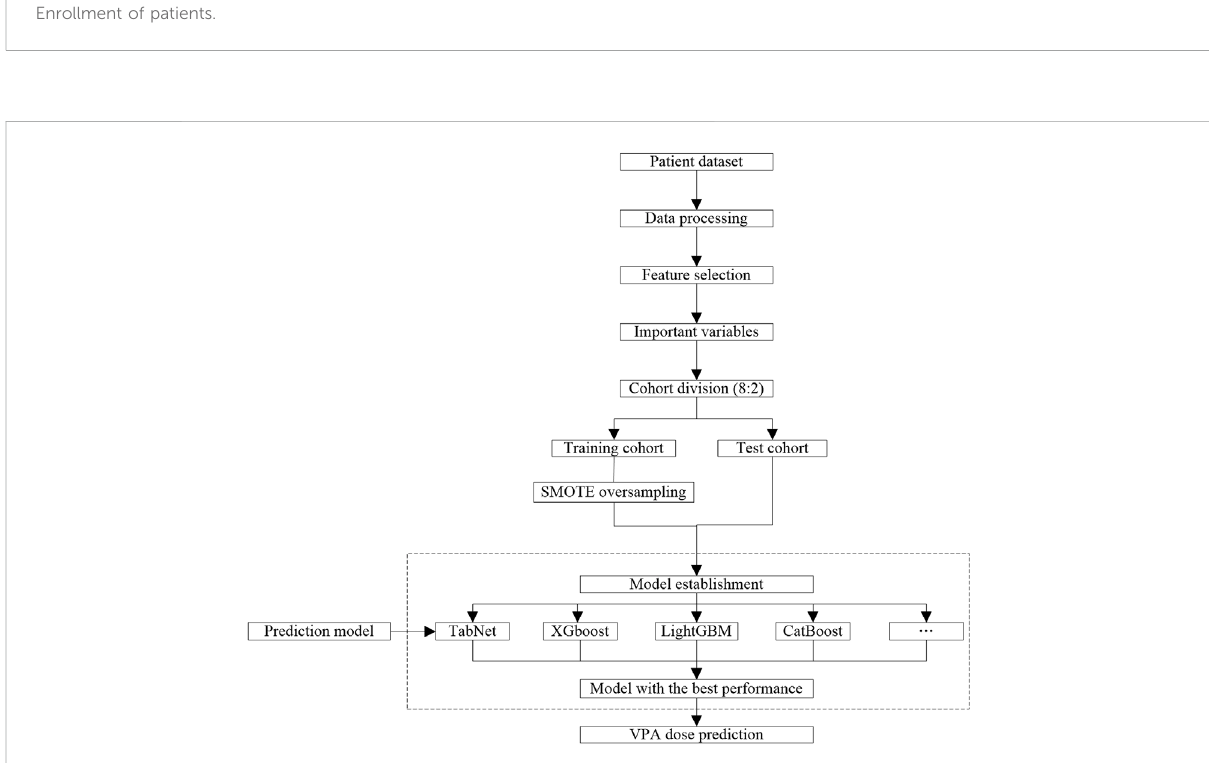
FIGURE 2 Work fl ow of data processing and